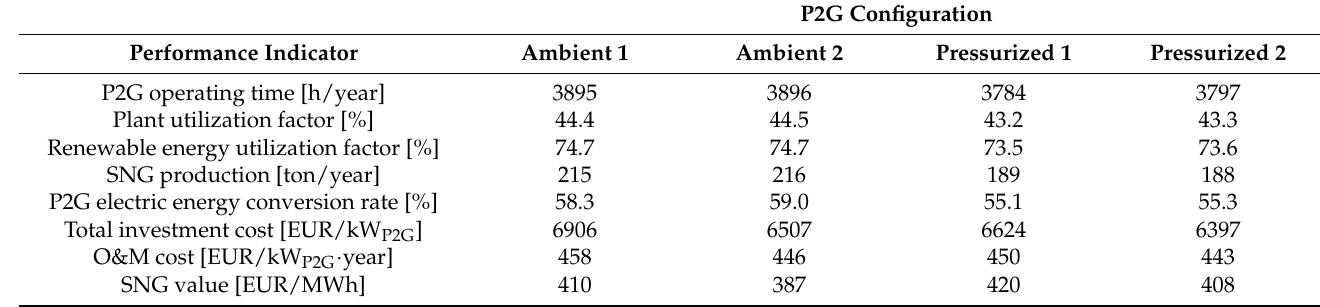
Table 4. Results of the comparative analysis among the P2G configurations in the reference techno- economic scenario (ratio between the P2G power size and the renewable generation peak power equal to 1/1.7—data referring to year 2019; SOEC specific investment cost equal to 5700 EUR/kW; no carbon tax